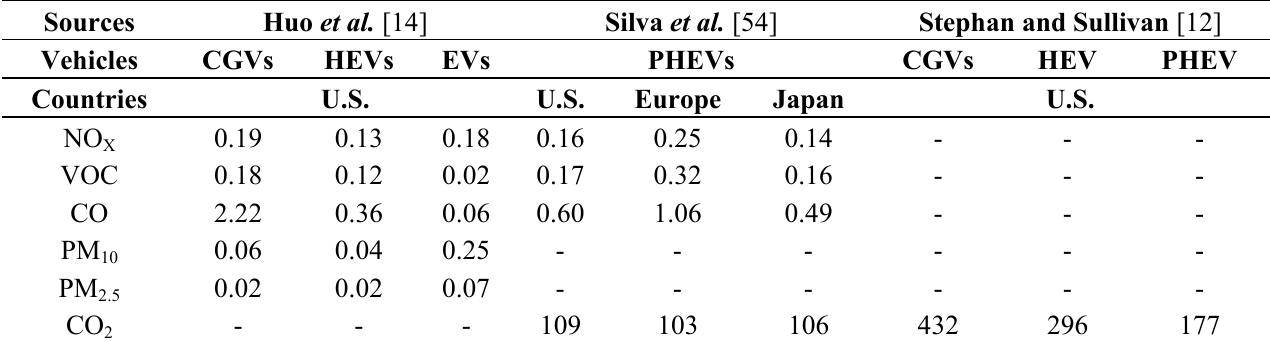
Table 11. The emission factors of CGVs, HEVs and EVs in other studies (g/km) [12,14,54].